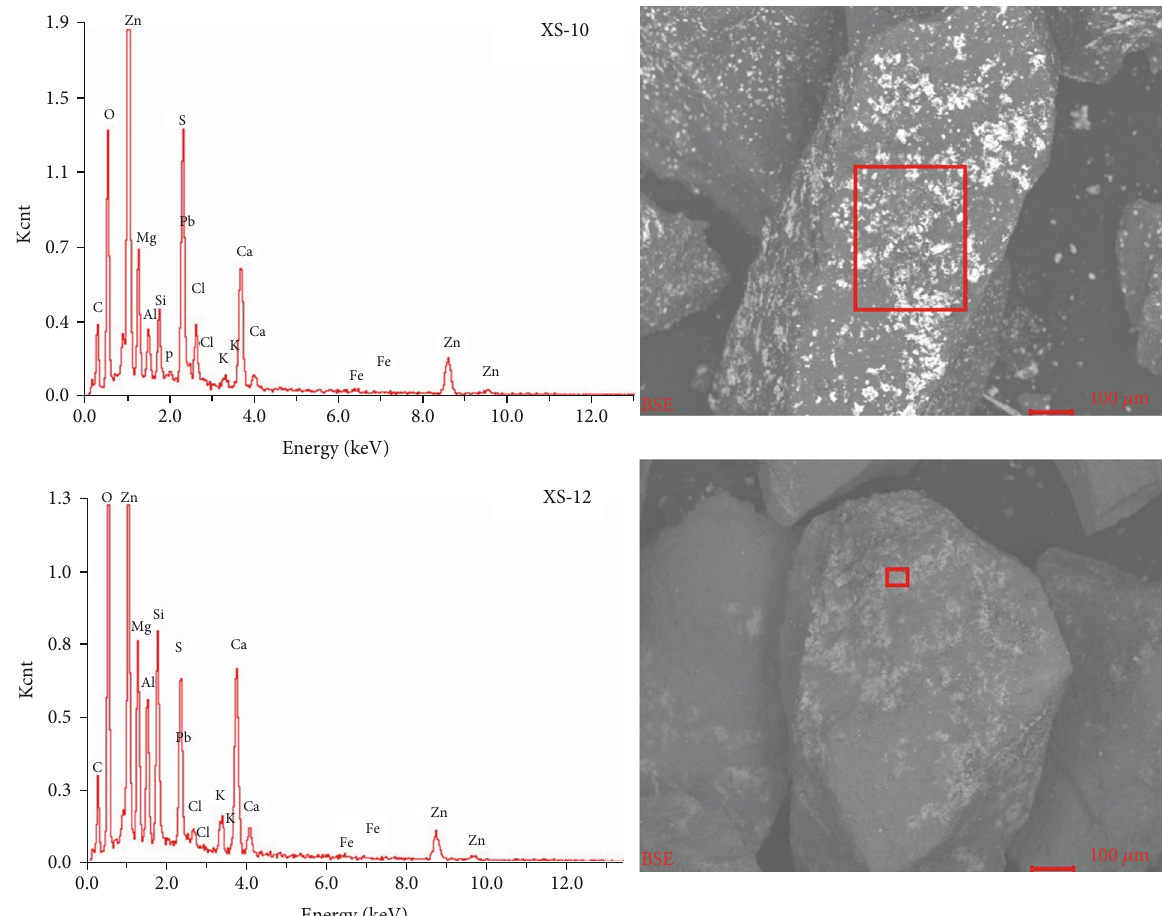
Figure 7: Electron probe patterns for XS-10 and